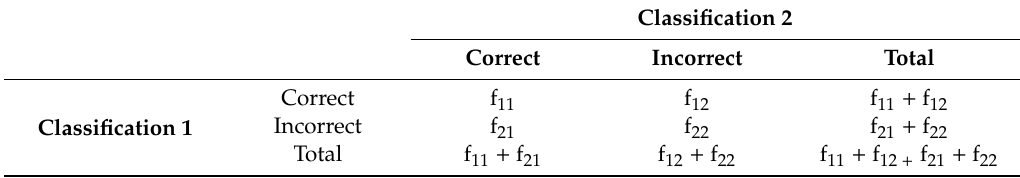
Table 1. Data layout for McNemar test between two classification results.